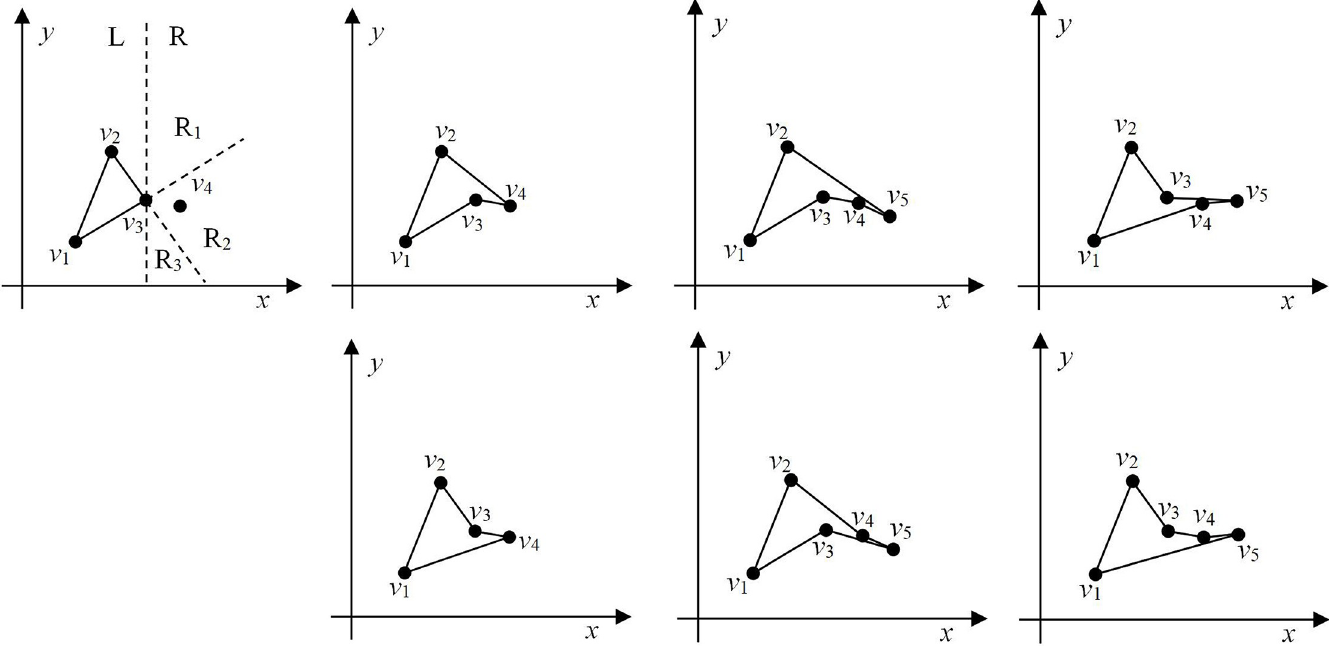
Fig 9. Polygons of different shapes constructed from different number of points. (a) Generation of the initial polygon, (b) polygon constructed from 4 points, (c) polygon constructed from 5 points.